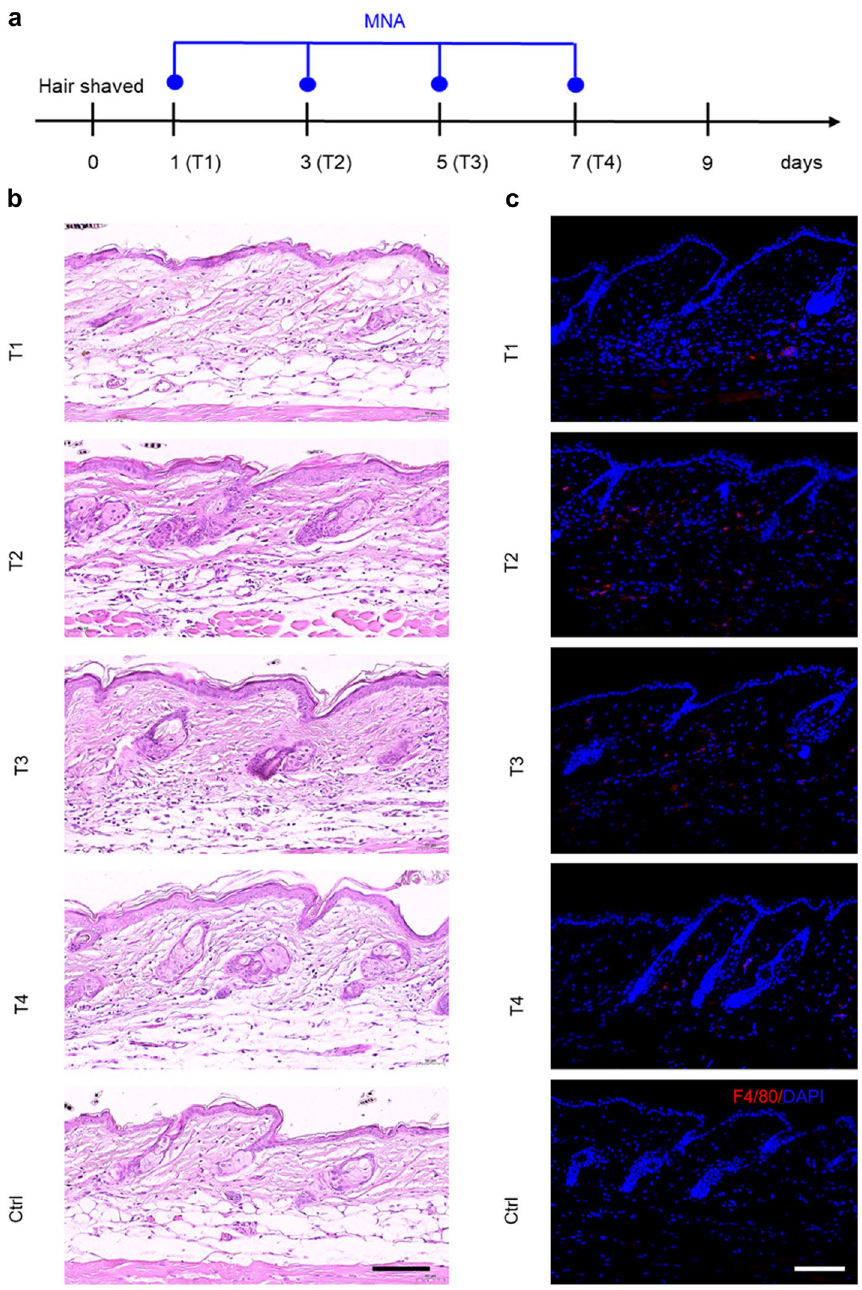
Fig. 6 Macrophages recruited in situ by MNA treatment. a Schematic diagram of animal treatment. b H&E staining showed a small amount of inflammatory cell accumulation after 1, 2, 3 and 4 (T1, T2, T3, T4) MNA treatments (Scale bar: 100 μm). c Immunofluorescence staining demonstrated the accumulation of macrophages after MNA treatment (Scale bar: 100